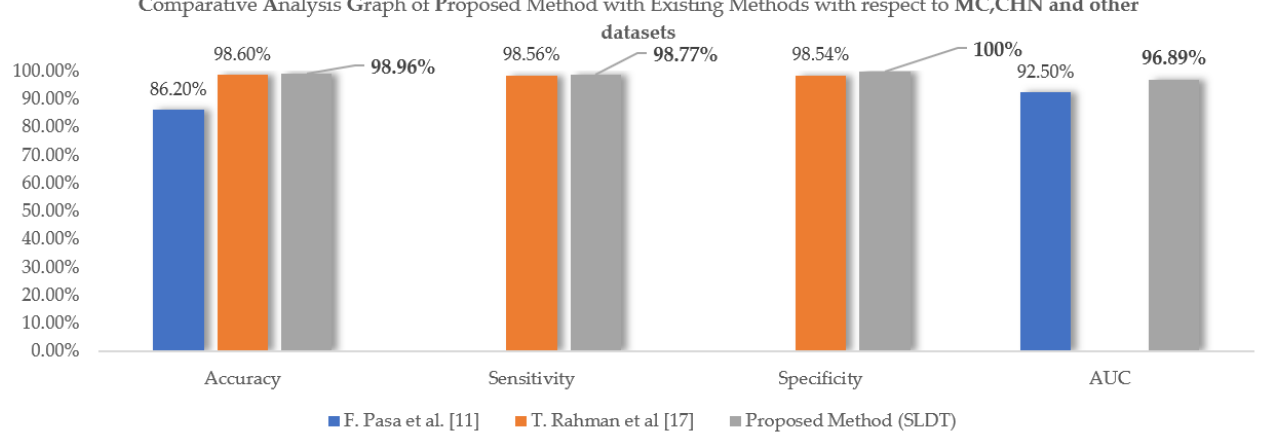
Figure 10. Comparative analysis graph of the proposed method with existing method with respect to the combined dataset 2 (NLM, Belarus, and RSNA).